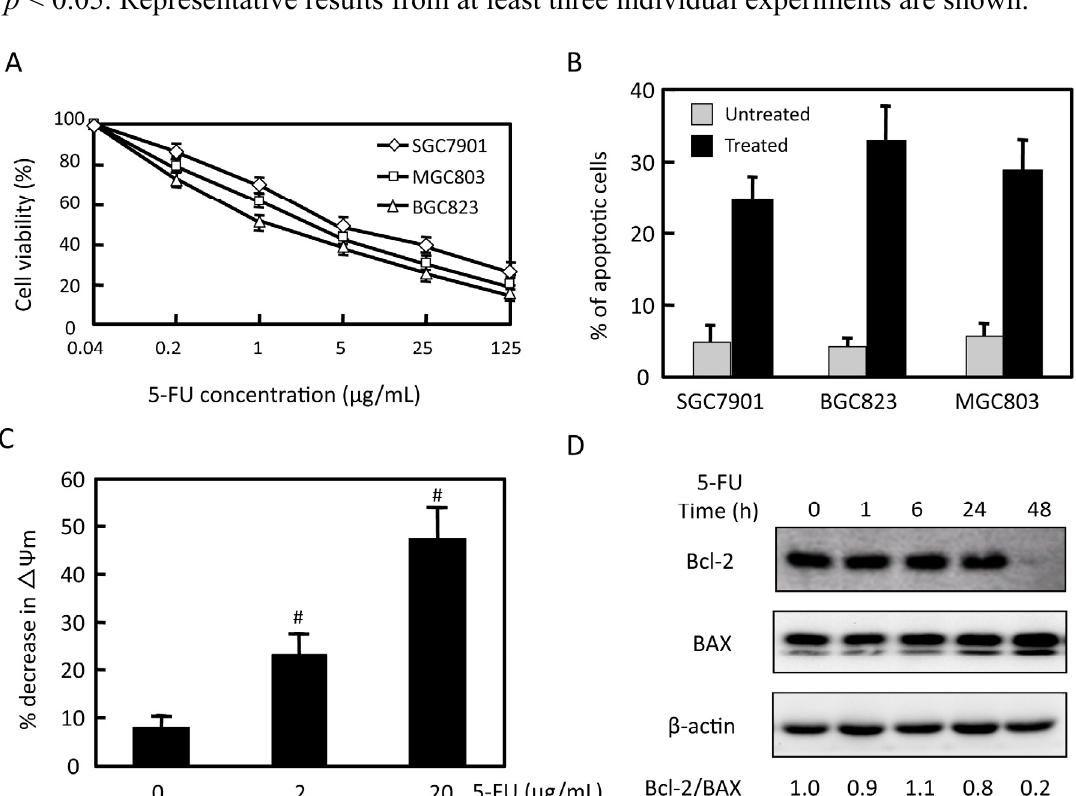
Figure 1. Effects of 5-FU on gastric cancer cell viability and apoptosis. ( A ) Three